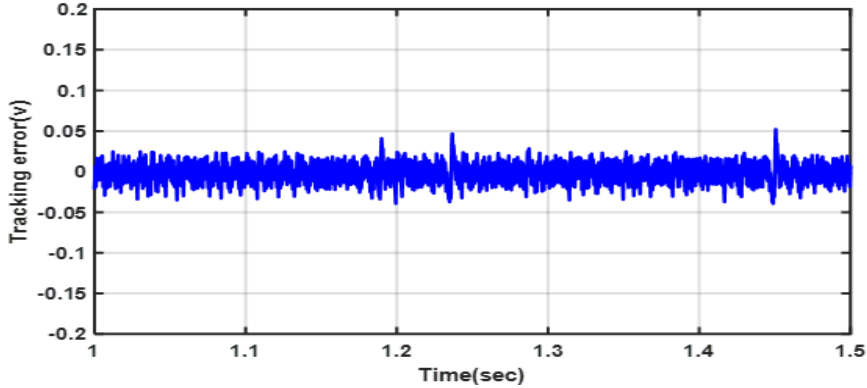
Figure 9. Tracking error between reference voltage and measured voltage.